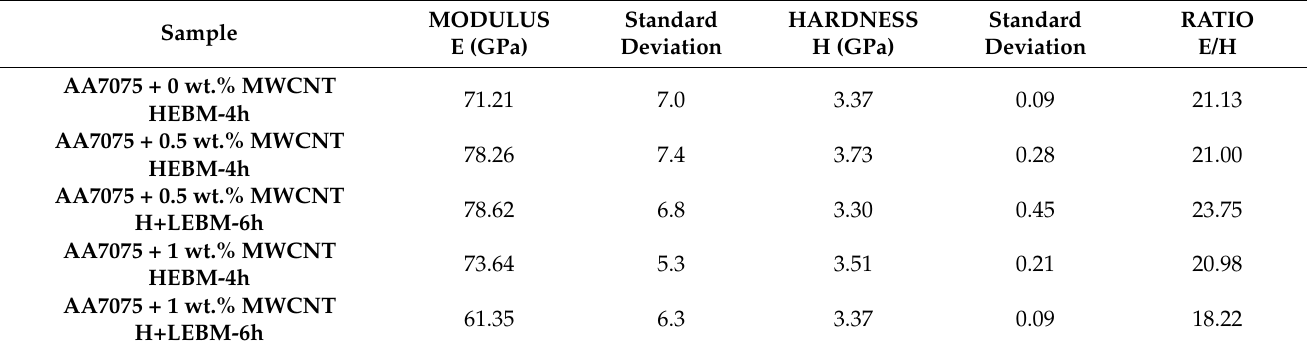
Table 5. Hardness and Young’s modulus